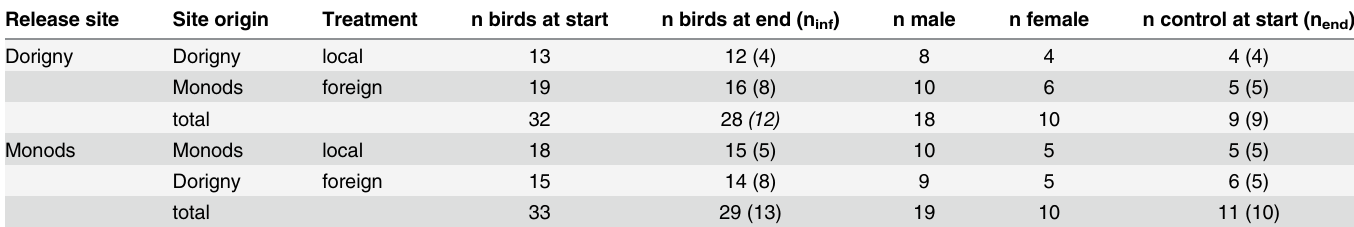
Table 1. Summary of sample